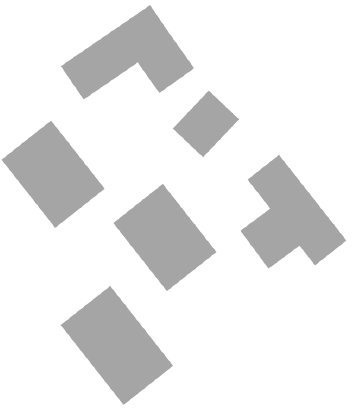
Figure 5. Scenario 2 - Customized Russel Road Buildings